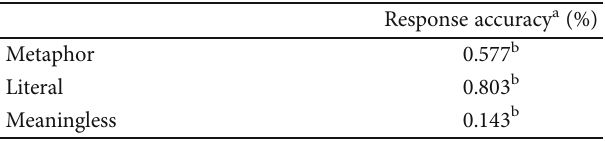
Table 2: Behavioural